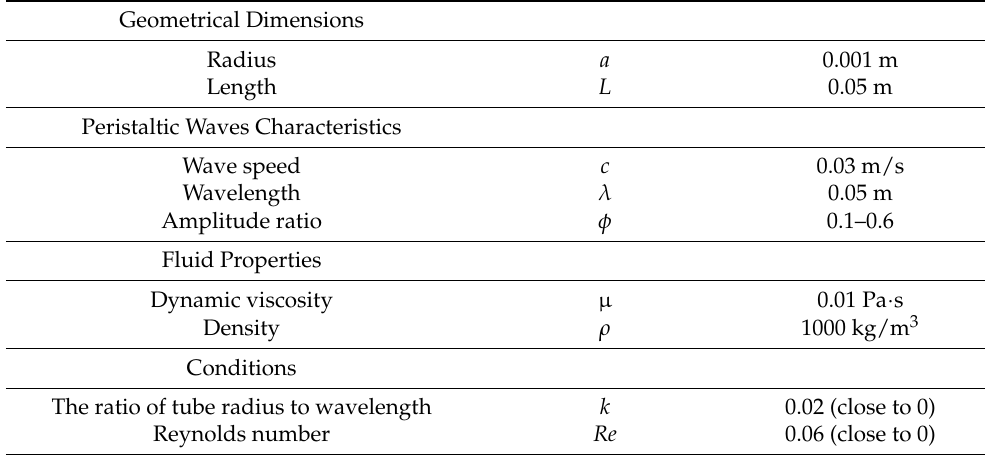
Table 1. Parameters used in the numerical models. Geometrical Dimensions Radius a 0.001 m Length Peristaltic Waves